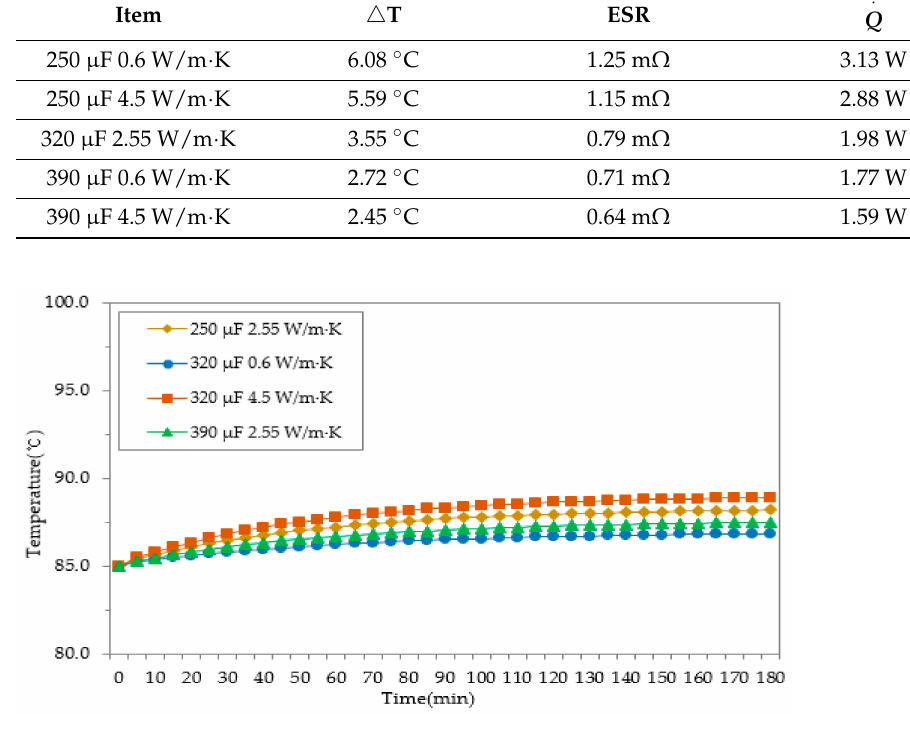
Figure 5. FEA results of capacitance and thermal conductivity epoxy for film thickness 3.5 µ